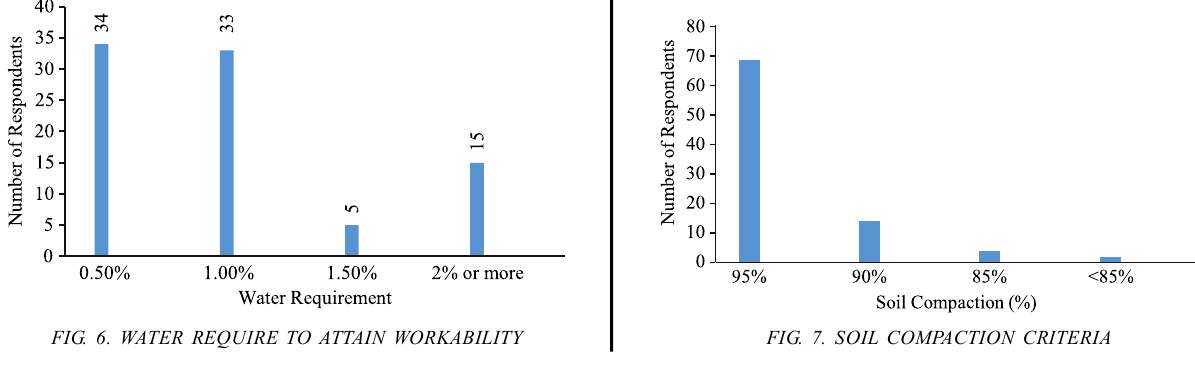
FIG. 7. SOIL COMPACTION CRITERIAFIG. 6. WATER REQUIRE TO ATTAIN